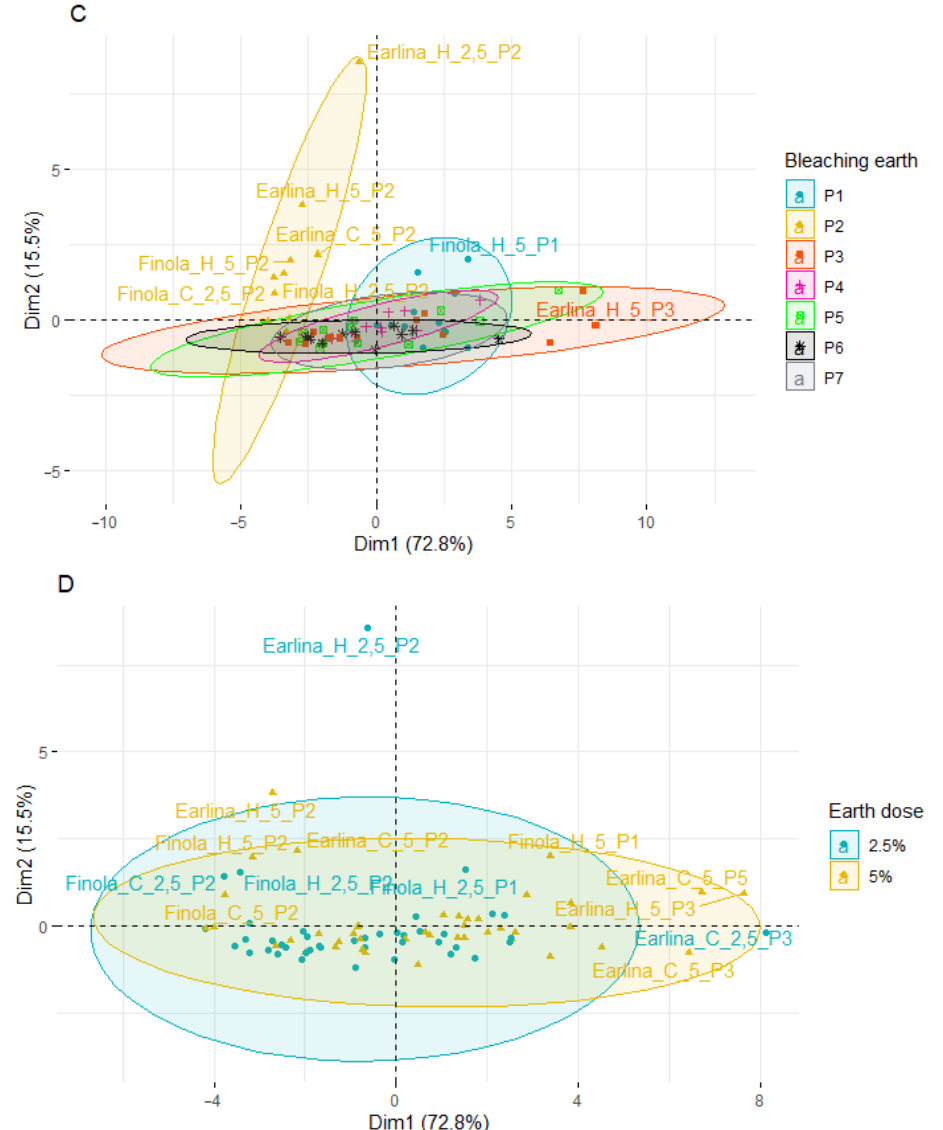
Figure 4. Principal component analysis (PCA) of the score plot of data from phytosterol content in extracted BE (mg/g) varieties ( A ), temperature of pressing process ( B ), type of bleaching earth ( C ), and earth dose ( D ).